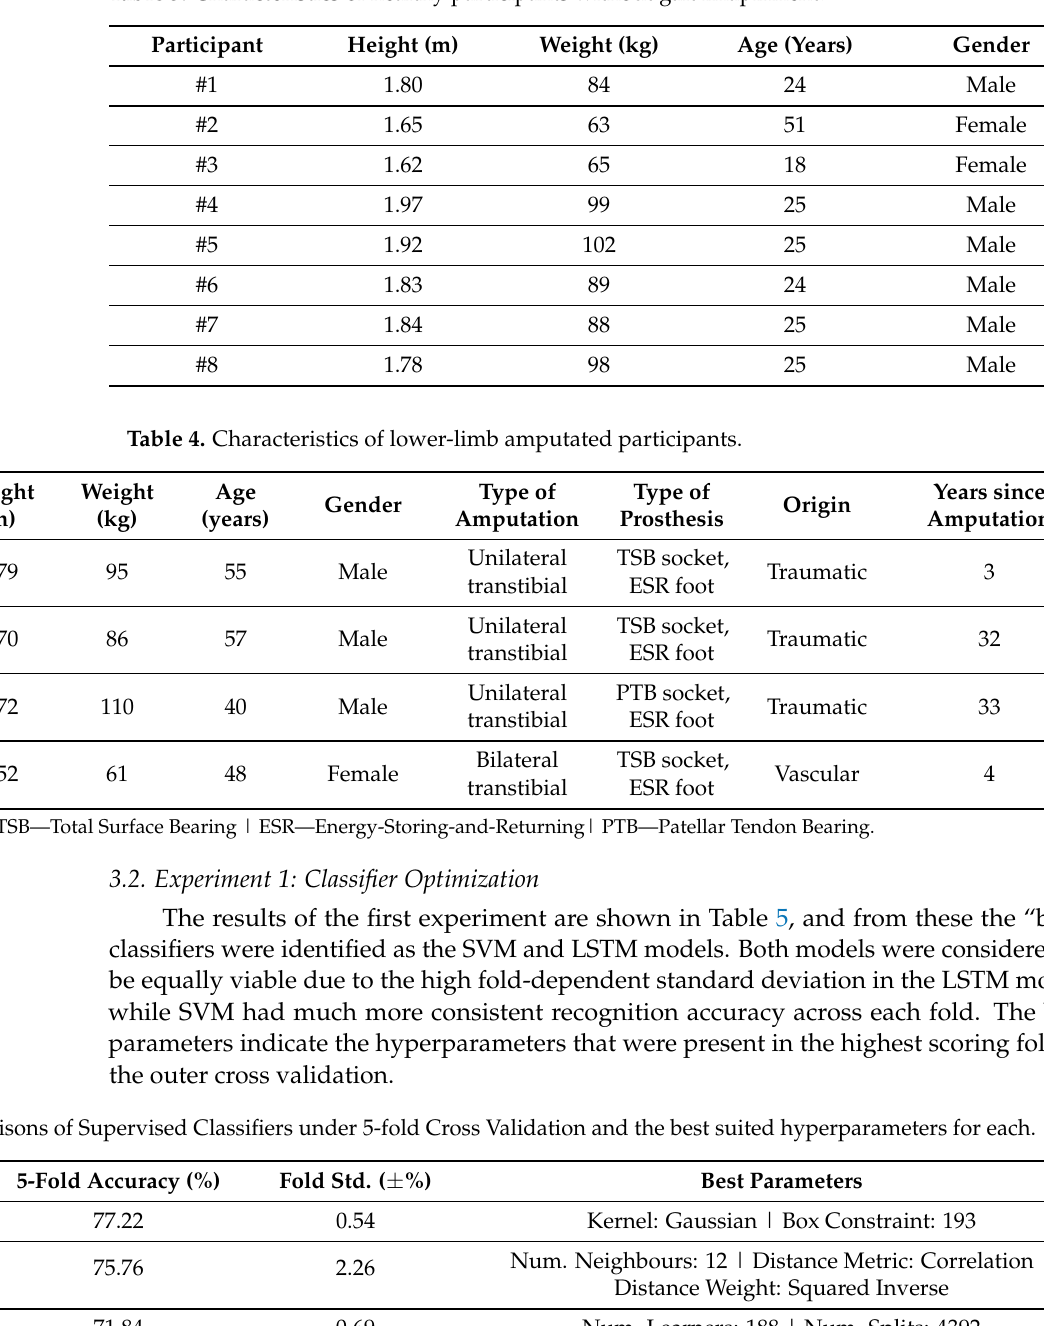
Table 3. Characteristics of healthy participants without gait imapirment.